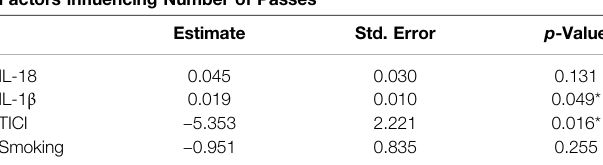
TABLE 2 | Logistic regression output of factors in fl uencing number of passes. Factors in fl uencing Number of Passes Estimate